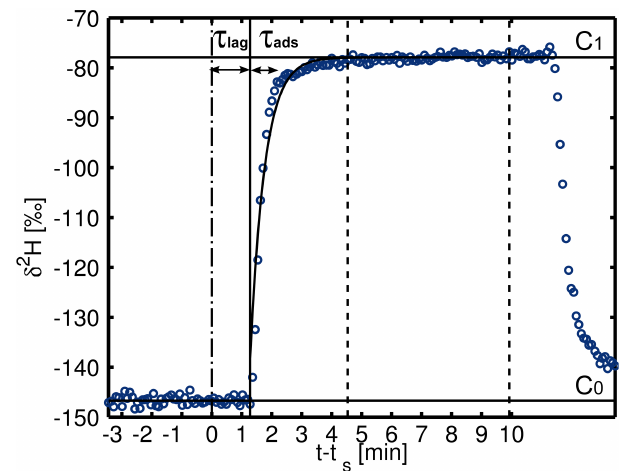
Fig. 11. Example of a response to a step change in δ 2 H as mea- sured by the L1115-i instrument. The total system response time consists of a time lag τ lag , which depends on the tubing length and pumping rate and an exponential time constant τ ads characterising the measured change in concentration from C 0 to C 1 , determined by the cavity gas exchange rate and the adsorption-desorption equi- librium on the tubing and cavity walls. The dashed lines delimit the data used for computing the concentration after the switch C 1 . The black dashed dotted line indicates the switch time of the valve, the black full line indicates the instant when the vapour front of the new sample arrives in the